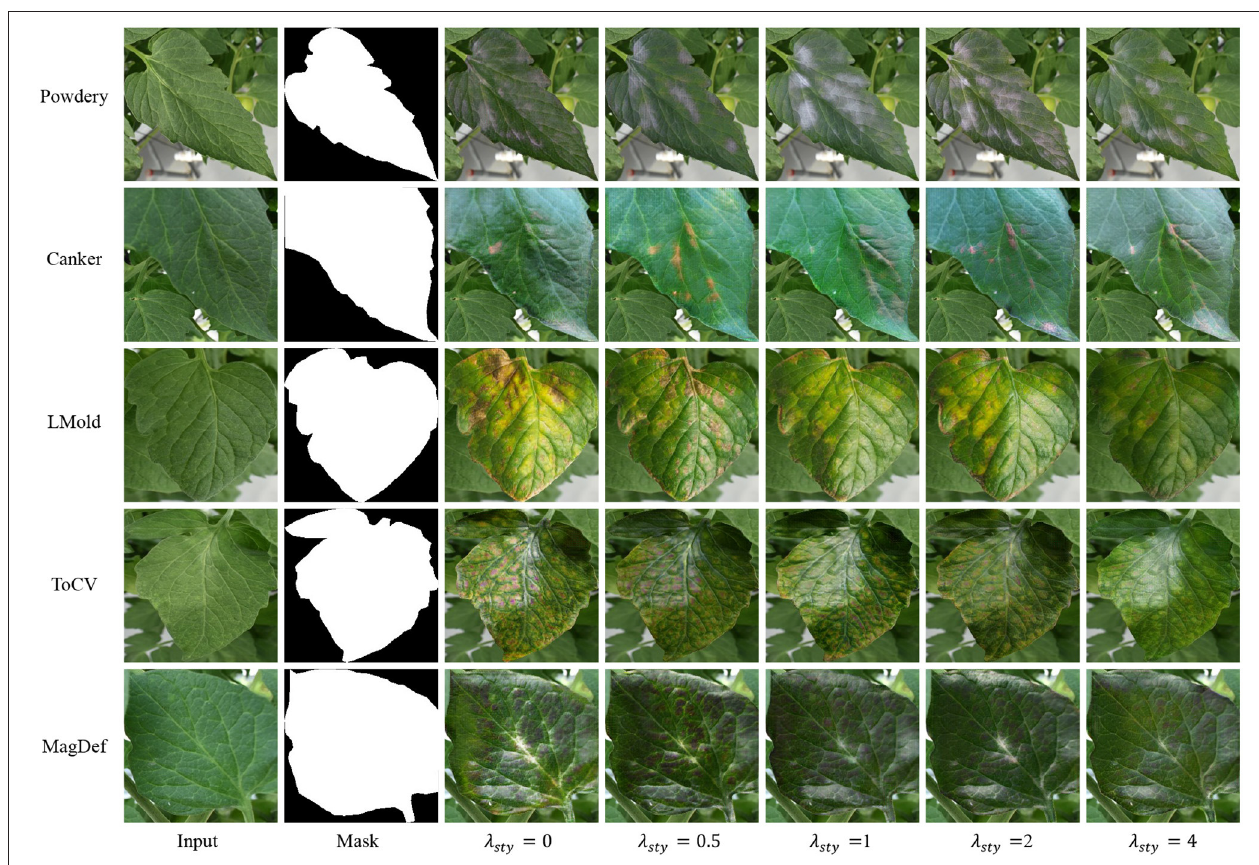
FIGURE 5 | Some generated images for image translation with different λ sty .